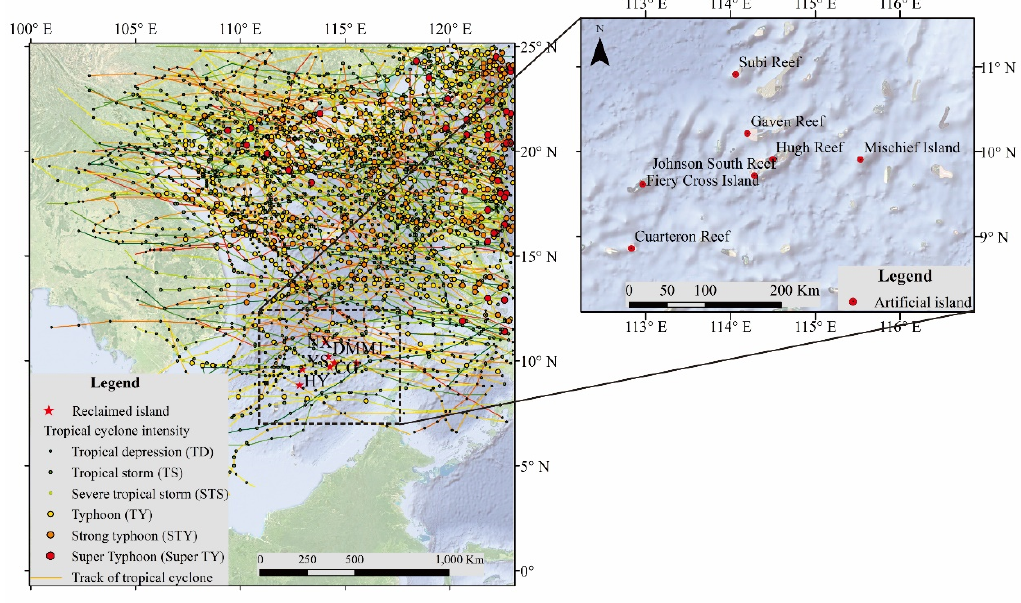
Figure 1. Map showing reclaimed islands in the SCS with the tracks and grades of the TCs.